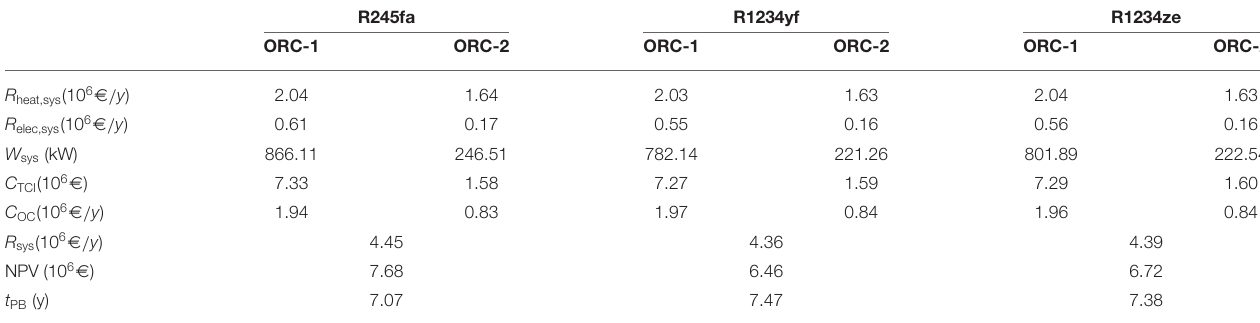
TABLE 2 | Main results obtained by maximizing the revenue from ORC